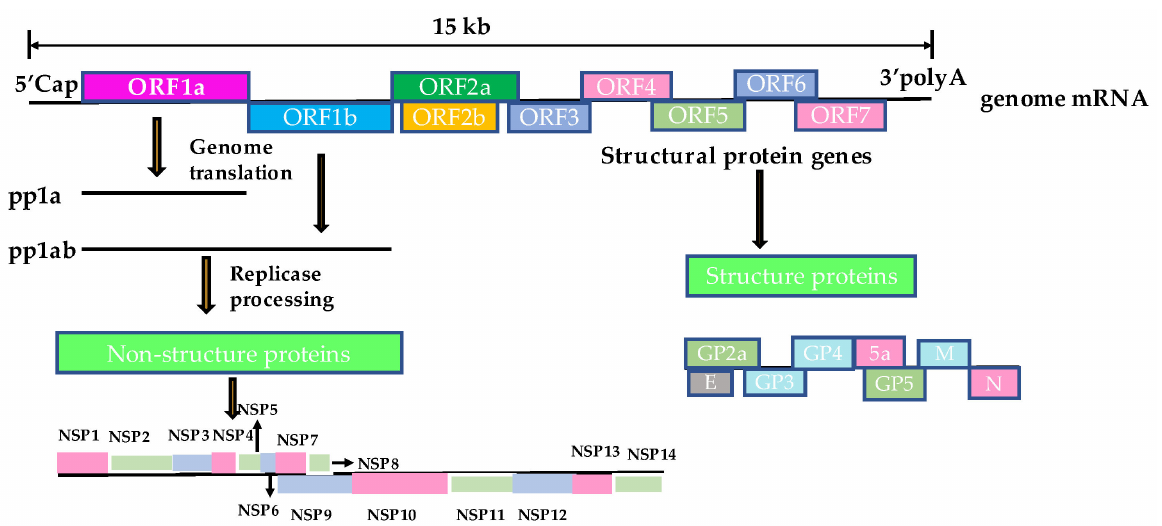
Figure 1. The structural mode of the PRRSV